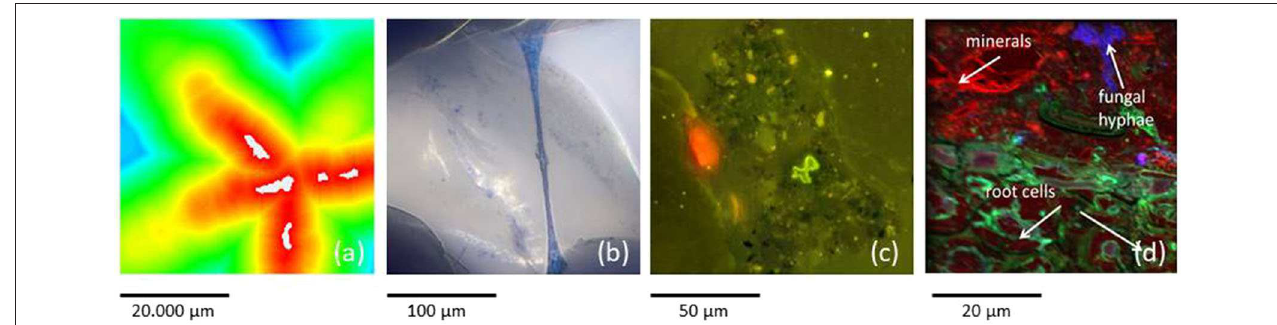
FIGURE 6 | Examples of 3D or 2D spatial patterns of components or relevance for rhizosphere research covering different scales. (a) Root distance map derived from X-ray CT scanning (Koebernick et al., 2014). (b) Light microscopy image of mucilage strands in quartz sand (Carminati, unpublished data). (c) FISH-stained bacteria colonizing quartz mineral and clay humus complex (Eickhorst and Tippkötter, 2008). (d) Composite image (NanoSIMS) of an embedded and polished root-soil interface. Minerals indicated by 16 O-(red); root cells by 12 C 14 N (green); fungal hyphae by 32 S-(blue), (Mueller, unpublished